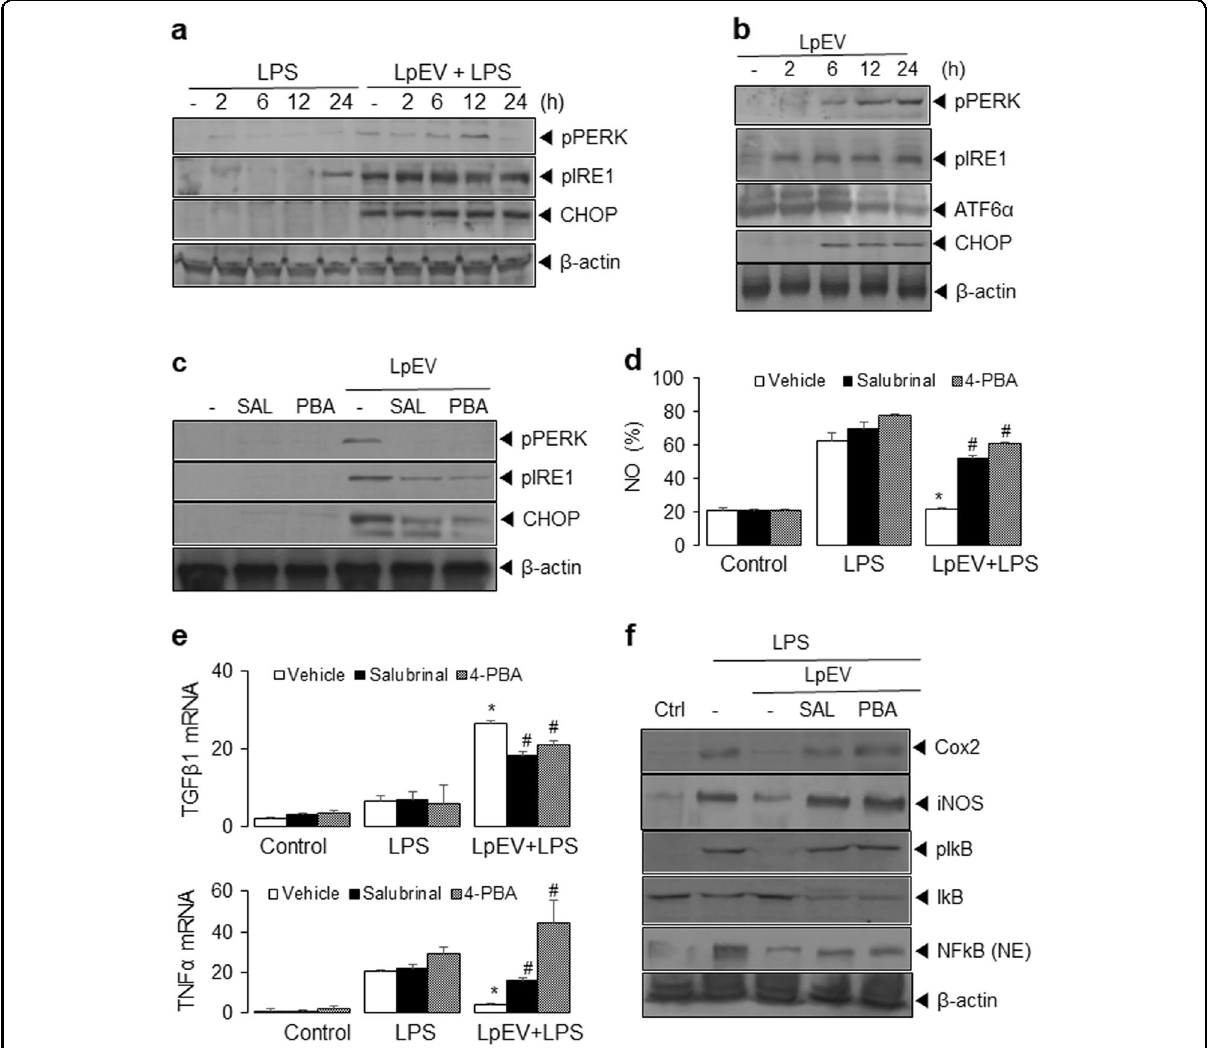
Fig. 6 Effect of LpEVs on ER stress-associated proteins in HT29 cells. a HT29 cells were pretreated with vehicle or 500 ng/mL LpEVs and then treated with 1 mg/mL LPS for 0, 2, 6, 12, and 24 h. b HT29 cells were treated with 500 ng/mL LpEVs for 0, 2, 6, 12, and 24 h. a , b Cell lysates were resolved by SDS-PAGE and analyzed by western blot analysis with antibodies against CHOP, p-PERK, p-IRE1, ATF6 α (p90), and β -actin. c HT29 cells were preincubated with 10 µM salubrinal or 5 mM 4-PBA for 1 h and treated with LpEVs for 12 h followed by LPS for 12 h. NO production was determined by a 2,3-diaminonaphthalene assay. d HT29 cells were preincubated with 10 µM salubrinal or 5 mM 4-PBA for 1 h, treated with LpEVs for 12 h, and then stimulated with LPS for 12 h. Cell lysates were analyzed by western blot analysis. e HT29 cells were preincubated with 10 µM salubrinal or 5 mM 4-PBA for 1 h, treated with LpEVs for 12 h and then stimulated with LPS for 0, 12, and 24 h. The mRNA levels of TNF α and TGF β were then analyzed by qRT-PCR. f HT29 cells were preincubated with 10 µM salubrinal or 5 mM 4-PBA for 1 h, treated with LpEVs for 12 h, and then stimulated with LPS for 0 and 24 h. Cell lysates were analyzed by western blot analysis with antibodies against iNOS, pI κ B, I κ B, and NF κ B. All data were plotted as the mean±standard deviation of at least three experiments. * P < 0.01 compared with LPS-treated cells without LpEVs. # P < 0.01 compared with LPS- treated cells with